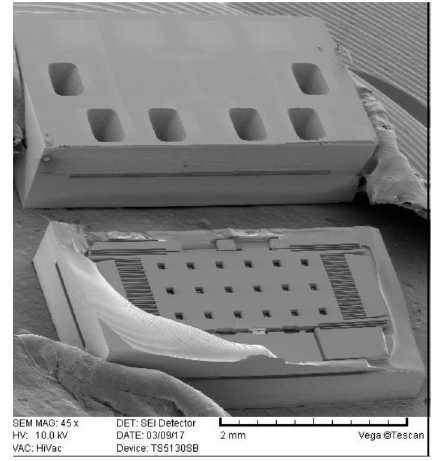
Figure 3. Fabrication process of MEMS switch.